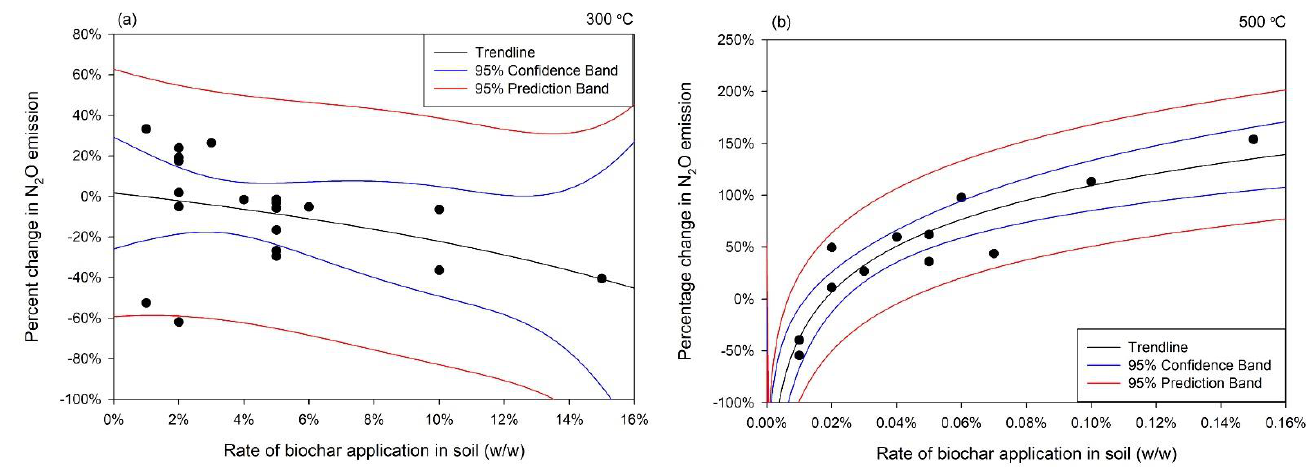
Figure 3. Percentage change in N 2 O emissions as affected by biochar applications at different application rates ( w / w ): ( a ) applied biochar was produced at approximately 300 °C and ( b ) applied biochar was produced at approximately 500 °C. Note: Different units for biochar application rates were all converted into weight percentage, calculated using the mass of applied biochar divided by the mass of impacted soil; the 0% (x-axis) refers to the control soil with no biochar added.